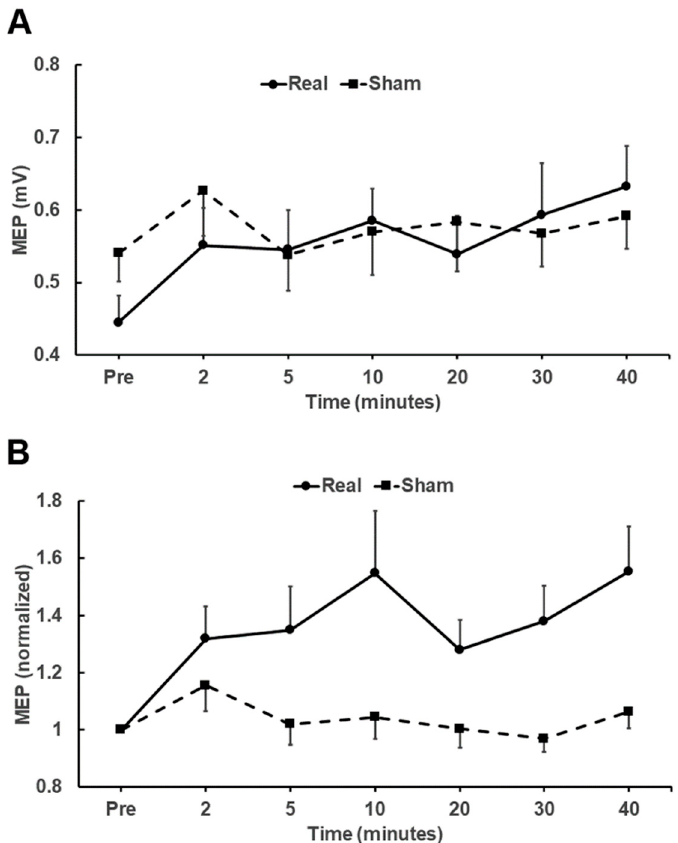
Figure 1. Raw ( A ) and normalized ( B ) mean MEP (± SEM) amplitudes (mV) recorded from the Tibialis Anterior muscle of both sides of all participants before and after 20 minutes of anodal stimulation (circles, uninterrupted line) and 20 minutes of sham stimulation (squares, dashed lines). MEP: Motor Evoked Potentials; SEM: Standard Error of Mean.